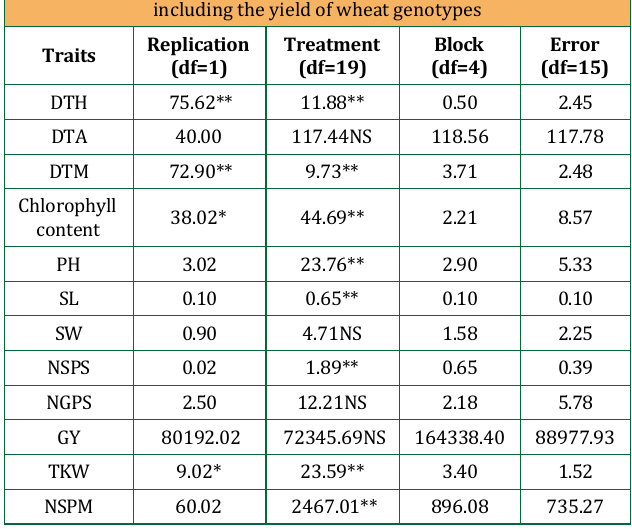
Table 2: Mean sum of the square of 12 important characters including the yield of wheat genotypes